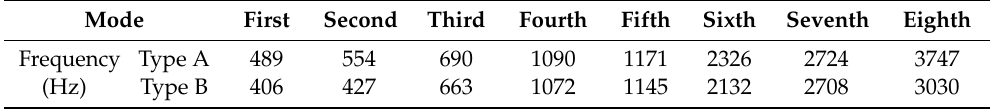
Figure 4. The eight mode shapes of the Type A flapper-armature assembly: ( a ) First mode; ( b ) second mode; ( c ) third mode; ( d ) fourth mode; ( e ) fifth mode; ( f ) sixth mode; ( g ) seventh mode; ( h ) eighth mode. Table 2. First eight order natural frequencies of the flapper-armature